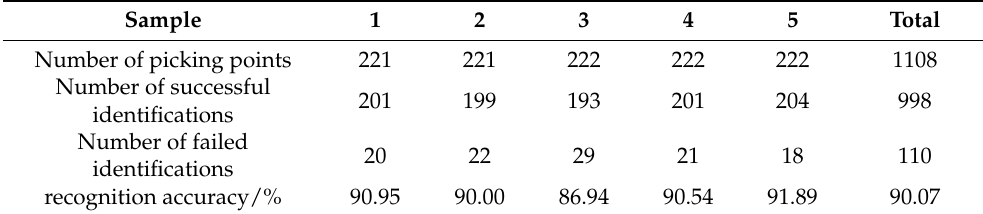
Table 9. Identification results of picking point for one bud with one leaf.